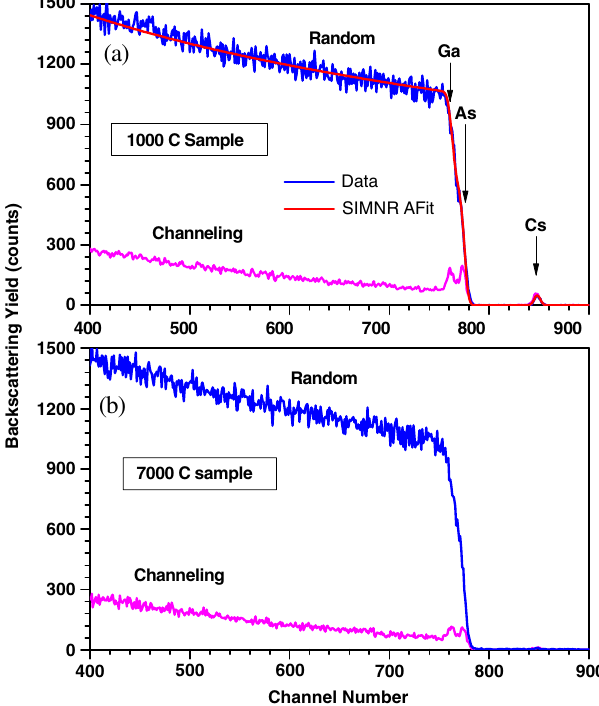
FIG. 5. Comparison of channeling and random RBS spectra (magenta and blue lines, respectively) for the 1000 coulomb sample obtained within the drive laser-illuminated region near the electrostatic center. The red line compares the RBS experi- mental random spectrum with the SIMNRA simulation. (b) Comparison of channeling and random RBS spectra (magenta and blue lines, respectively) for the 7000 coulomb sample obtained within the drive laser-illuminated region near the electrostatic center.